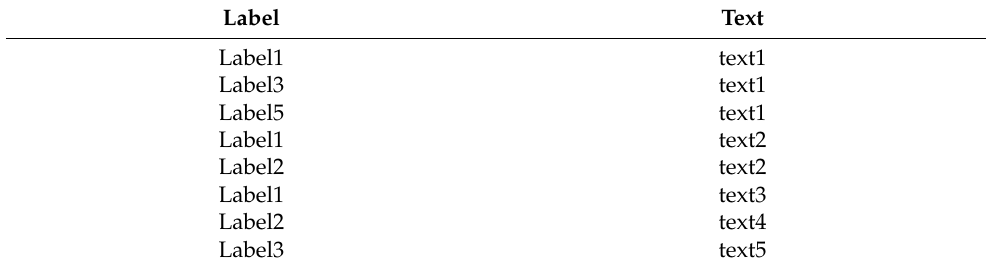
Table 3. The data format after transformation by DM